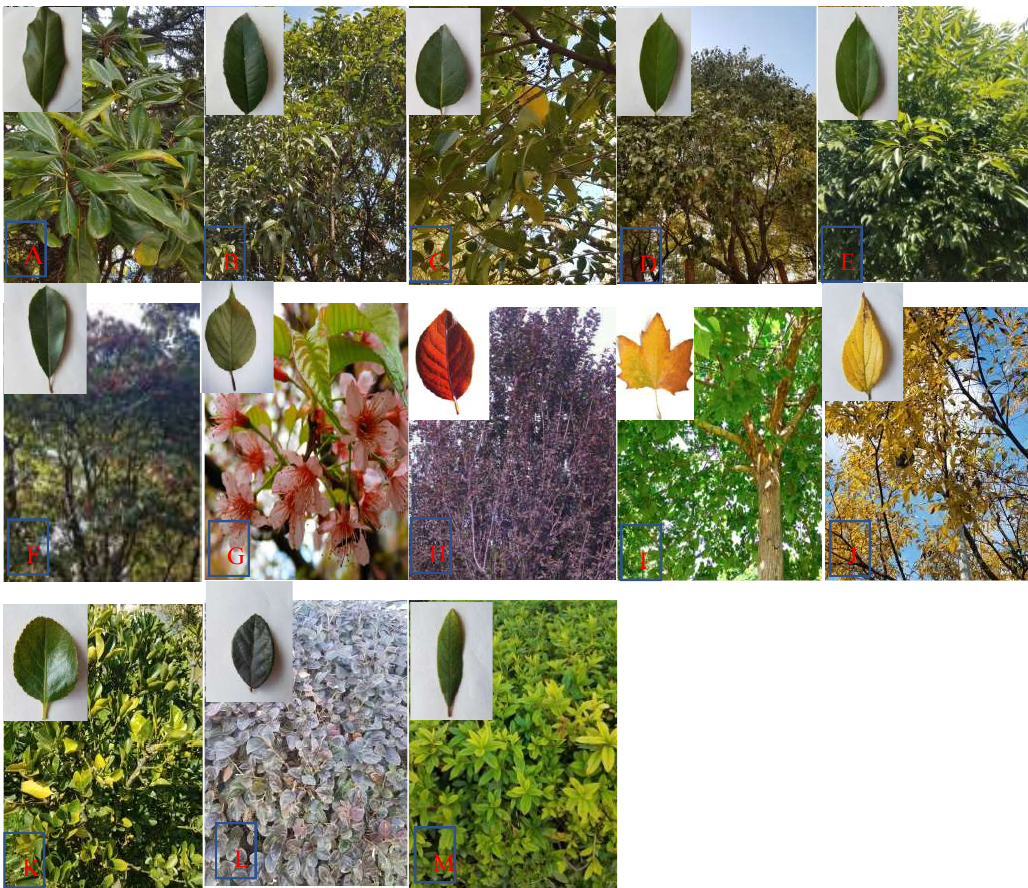
Figure 1. Pictures of the selected thirteen plant species in Kunming City. A: Magnolia grandiflora Linn; B: Osmanthus fragrans (Thunb.) Lour.; C: Ligustrun lucidum Ait; D: Cinnamomum camphora (L.) Presl.; E: Cinnamomum japonicum Sieb; F: Photinia glomerata Rehd. et Wils; G: Prunus majestica Koehne; H: Prunus cerasifera f. atropurpurea; I: Platanus acerifolia Ait.; J: Celtis kunmingensis Cheng et Hong; K: Euonymus japonica Thunb.; L: Loropetalum chinense var. rubrum; M: Rhododendron pulchrum Sweet. Table 1. Plant species used and clustering analysis with the surface accumulation of particulate matter (PM) as variables. Cluster in Species Family